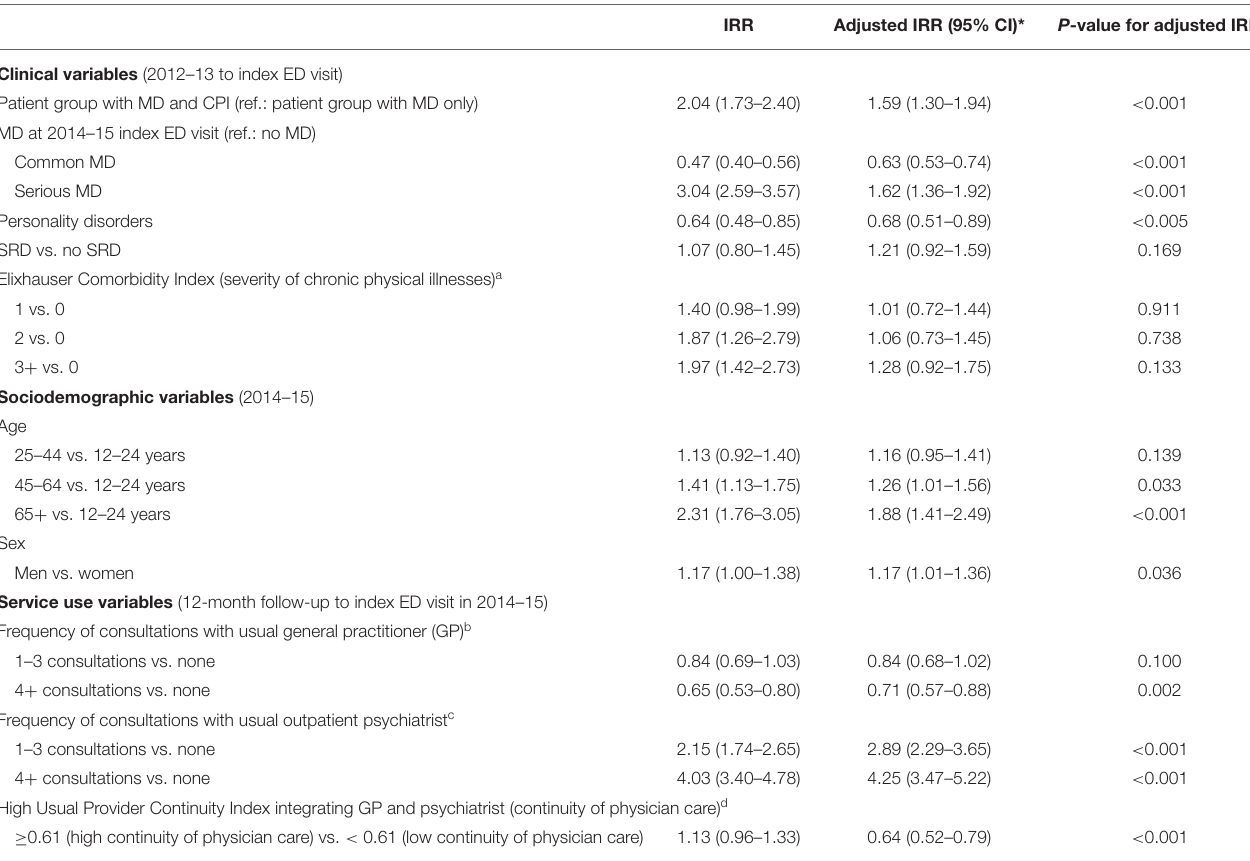
IRR Adjusted IRR (95% CI)* P -value for adjusted IRR